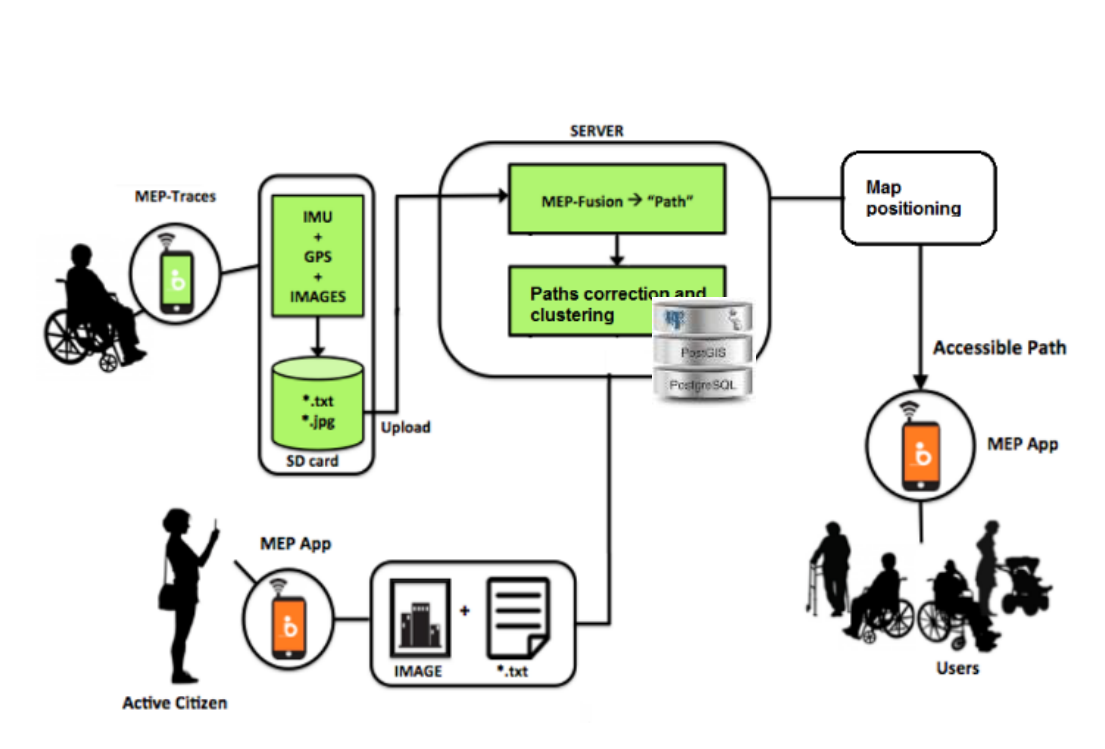
Figure 1 . Overview of the process for data collection and